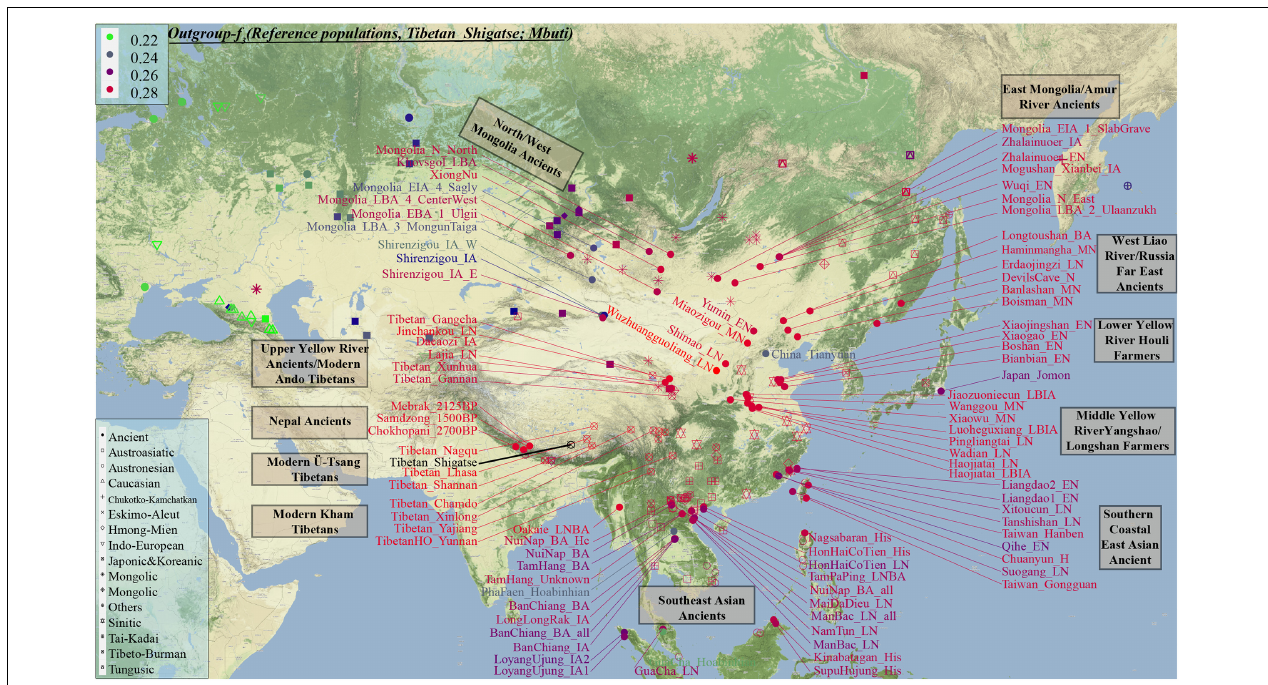
FIGURE 3 | The genomic affinity between our Shigatse Tibetan populations and other modern and ancient spatial-temporally different eastern Eurasian populations. The red color denoted a stronger genetic affinity with Shigatse Tibetans, and the blue color showed a lower genetic